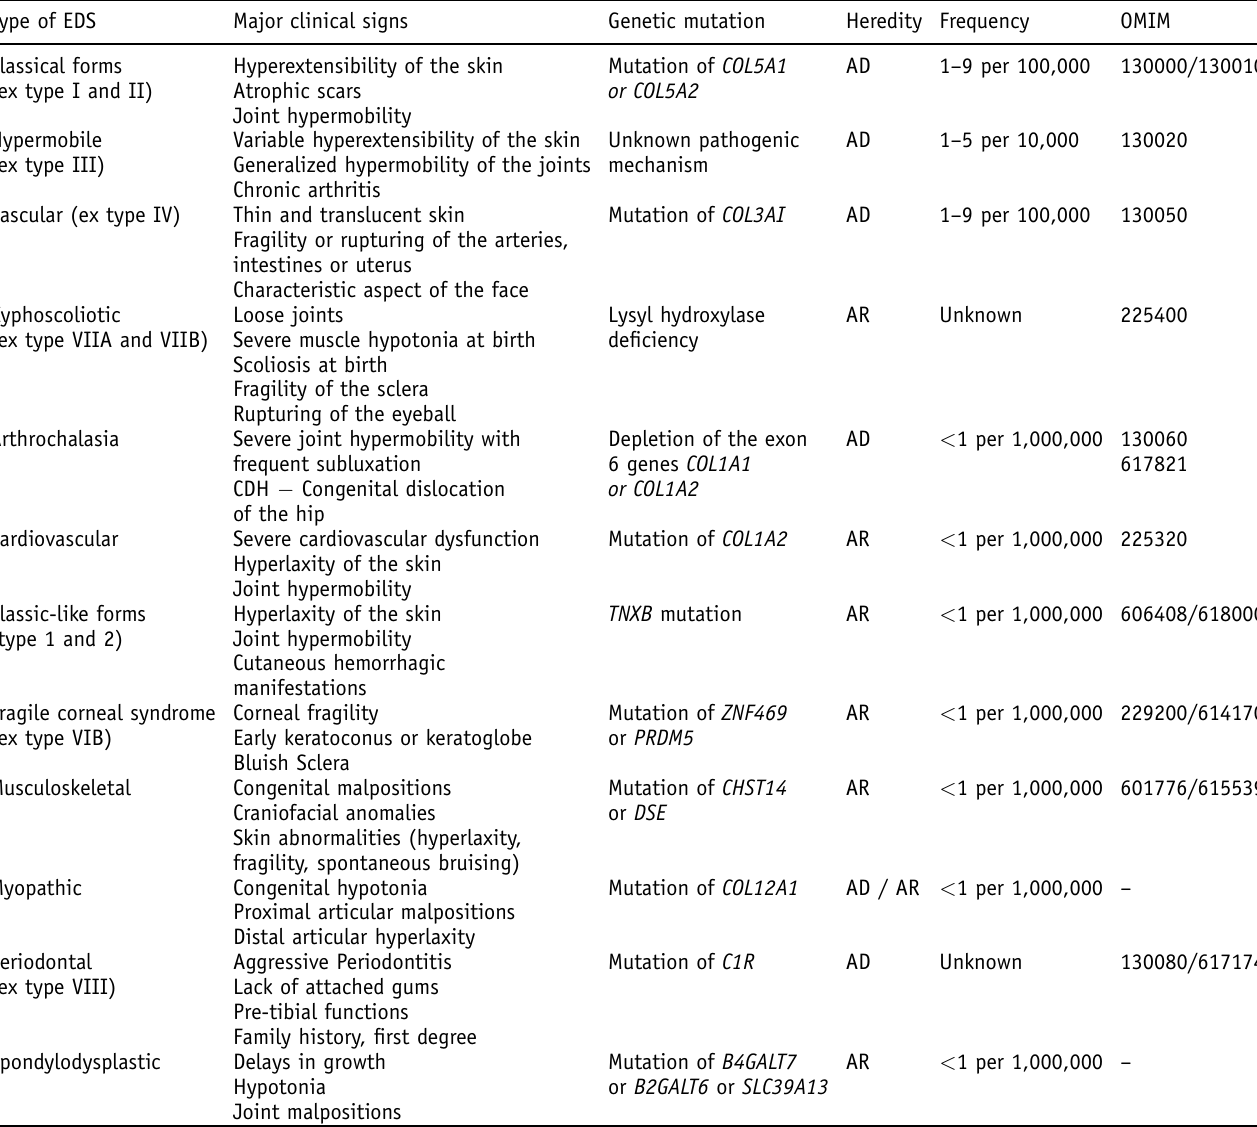
Table I. The Villefranche classi fi cation of EDS (Beighton et al., 1997 [4]). Most common types of EDS (cid:1) COL: collagene; AD: autosomal dominant; AR: autosomal recessive; OMIM: Online Mendelian Inherance in